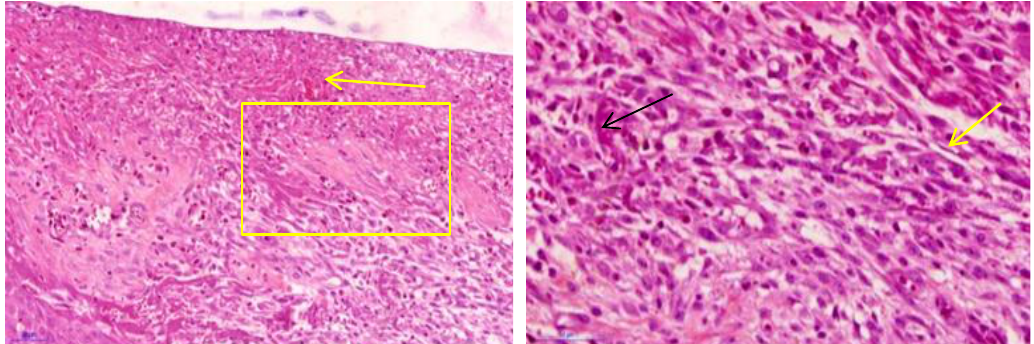
Figure 6: Microphotograph of study group treated with gingival sulcular irrigation of 50 μL/kg of 5% green tea extract after one day showing moderate inflammatory cell infiltration with slight fibroblastic activity, mild bleeding and ulcerative sulcular epithelium (arrows). H&E x20, x40.